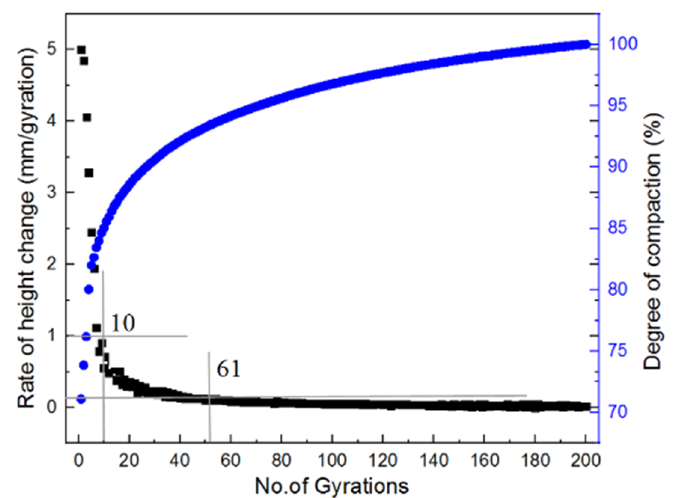
Figure 10. The rate of height change and degree of compaction versus the number of gyrations for the specimen with an optimal combination of gyratory compaction parameters.